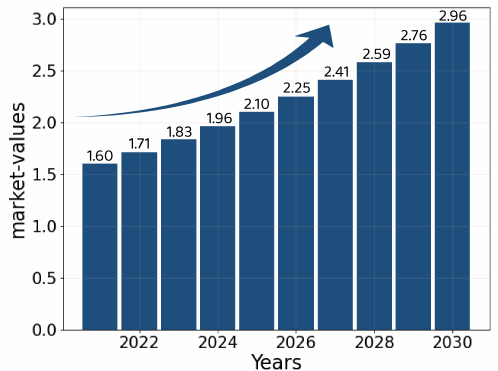
Figure 1. Blockchain-based cryptocurrency market